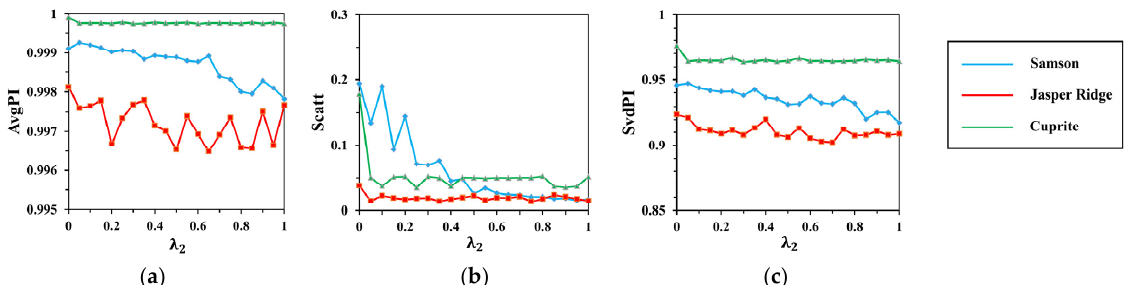
Figure 10. The results of ( a ) Scatt; ( b ) AvgPI; ( c ) SvdPI with the change of λ 2 .